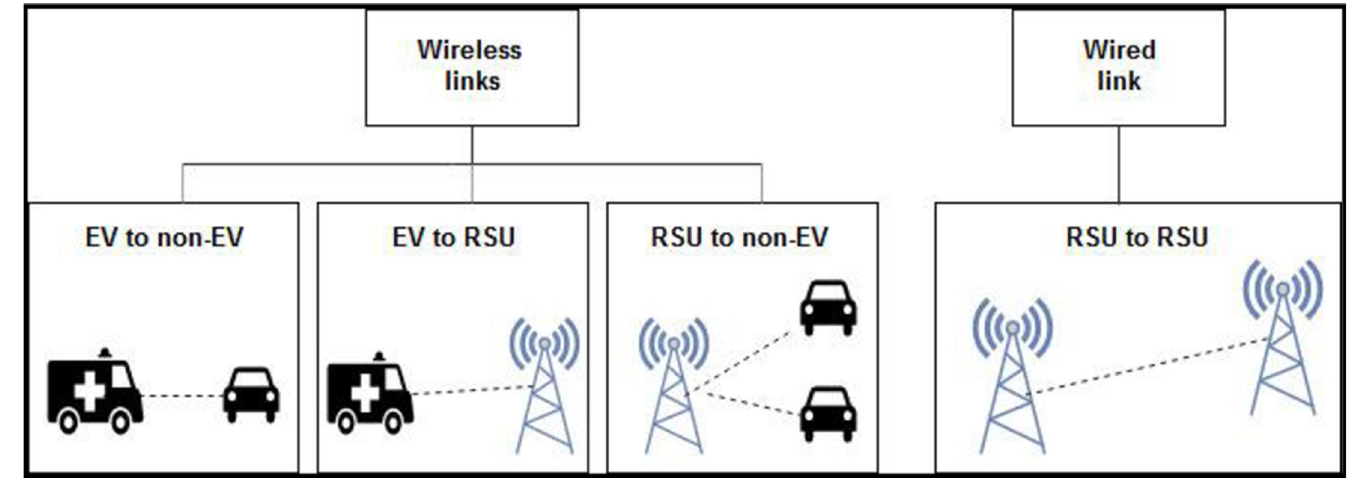
Fig 5. Communication links in the proposed